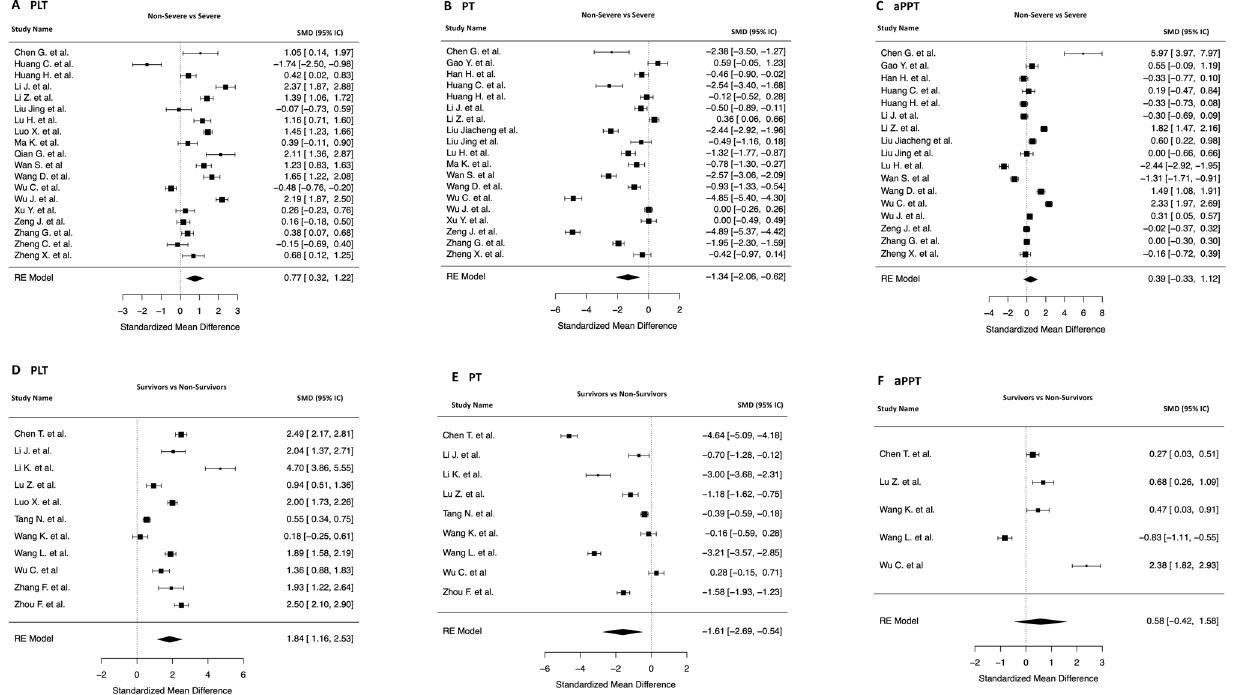
Figure 4. Forest plots of the standardized mean difference in platelets count (PLT), prothrombin time (PT) and activated partial thromboplastin time (aPTT). ( A – C ) Forest plots of the standard mean difference in PLT count, PT and aPTT between Non Severe and Severe patients. ( D – F ) Forest plots of the standard mean difference in PLT count, PT and aPTT between Survivors and